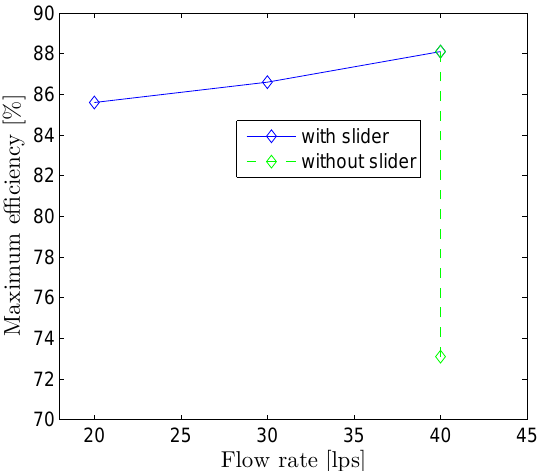
Figure 10. Part-load performance of the slider control on the double-nozzle runner at maximum efficiency, H = 1.337 m and ω = 199 RPM.